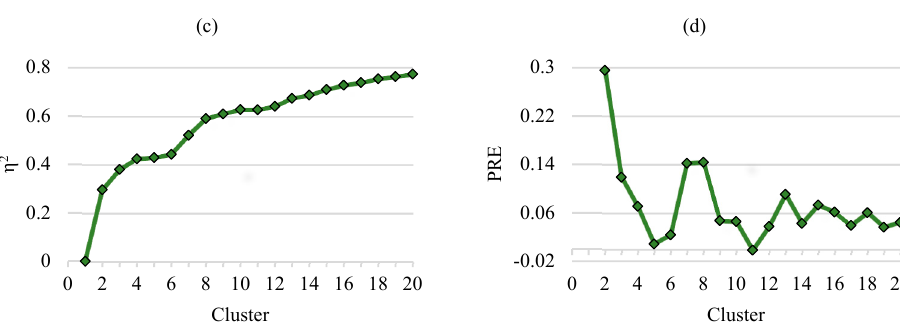
Figure 1. ( a ) within sum of squares ( WSS ), ( b ) log ( WSS ), ( c ) η 2 , and ( d ) proportional reduction of error ( PRE ) for all K cluster solutions.